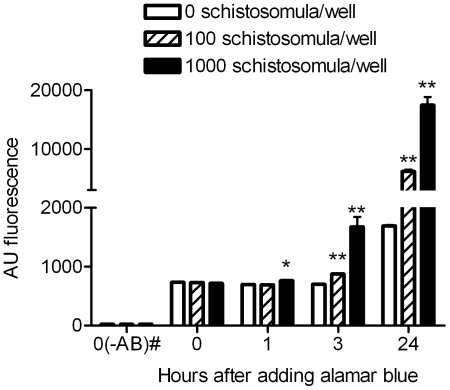
Alamar blue fluorescence development following culture with schistosomula.Wells contained 0, 100 (500/ml) or 1000 (5000/ml) schistosomula. # Wells containing schistosomula but no Alamar blue at time 0 (these values did not alter with time in culture). * P<0.01, ** P<0.0001 relative to wells with no schistosomula added. The mean ± standard deviation of fluorescence, expressed in arbitrary units (AU), is based on 5 replicate wells.